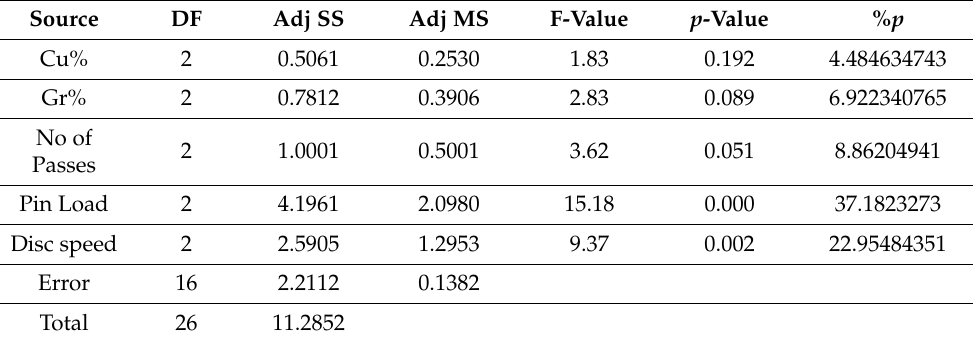
Table 4. Analysis of variance (ANOVA) for wear rate of the composites prepared by FSP Tool A.